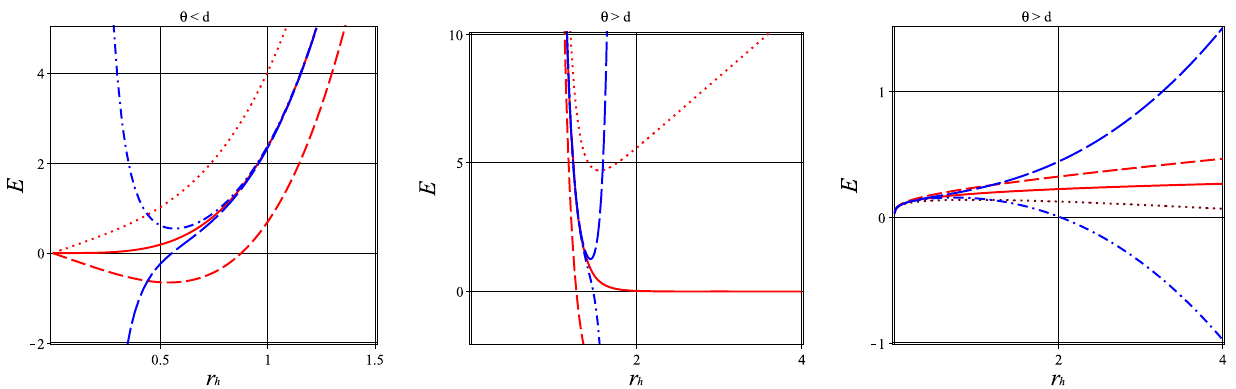
Fig. 1 Internal energy in terms of r h . We set unit values for all param- eters in this model. Left θ < d for θ = 1, d = 9. Middle θ > d for θ = 10, d = 2. Right θ > d for θ = 10, d = 8. α = 0 . 5, γ